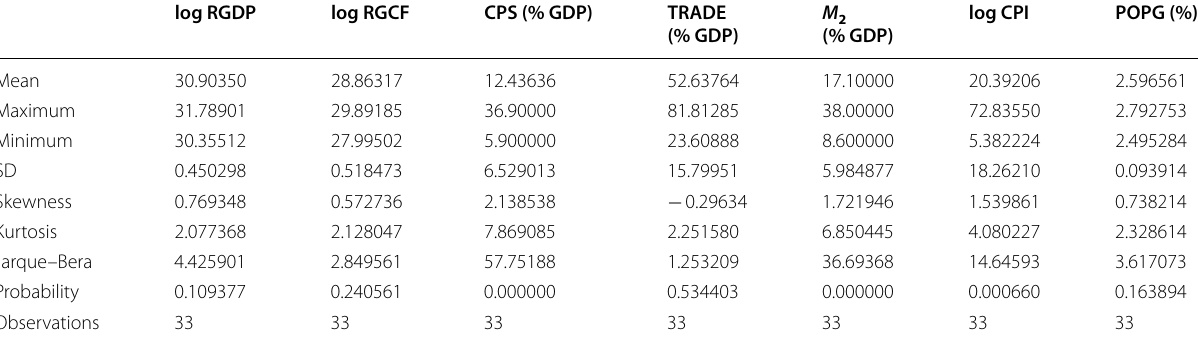
Table 2 Summary of statistics. Source : Computed by the Researchers,